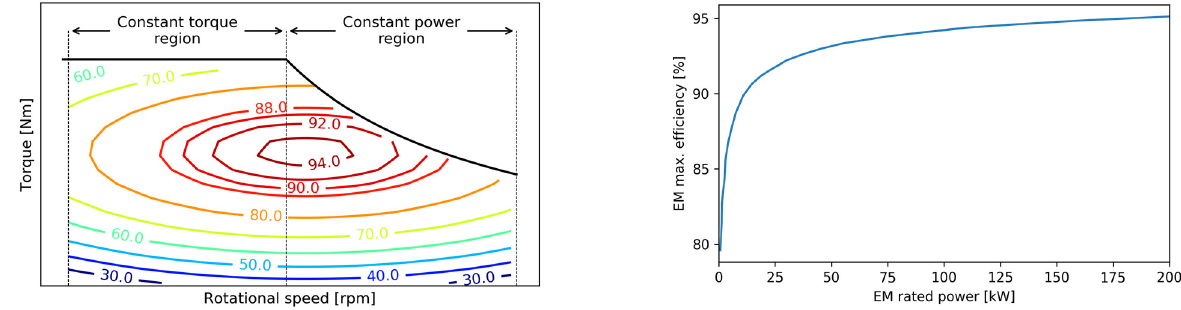
Figure 2. EM efficiency and generic full load curve ( left ) and maximum efficiency as function of rated power ( right ). Right figure based on Larsson [24] and authors’ further elaboration.